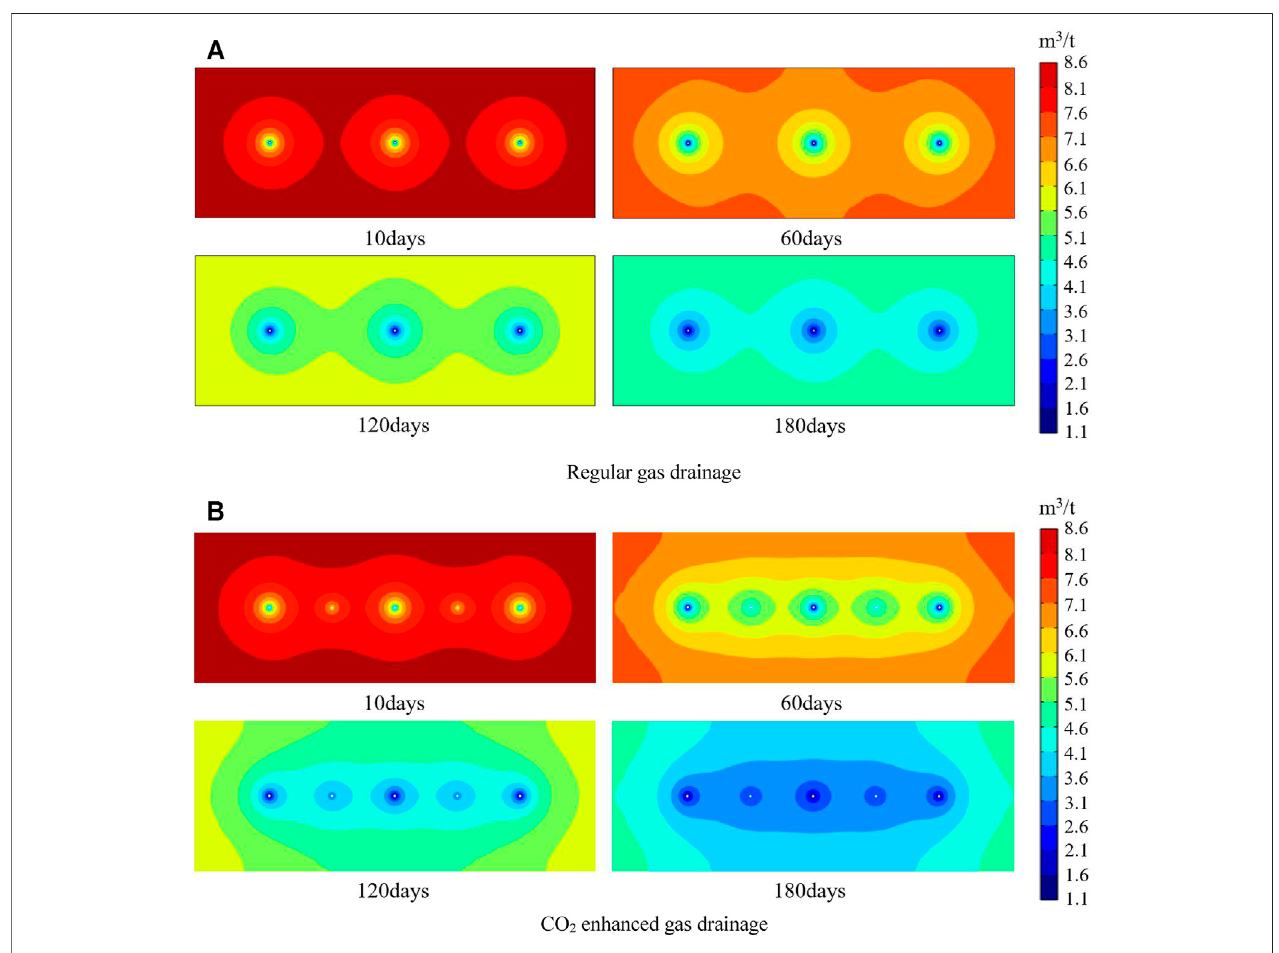
FIGURE4| ContourofCH 4 contentofbothregular and CO 2 enhanced gasdrainage atdifferenttimes. (A) Regulargasdrainage. (B) CO 2 enhanced gasdrainage.